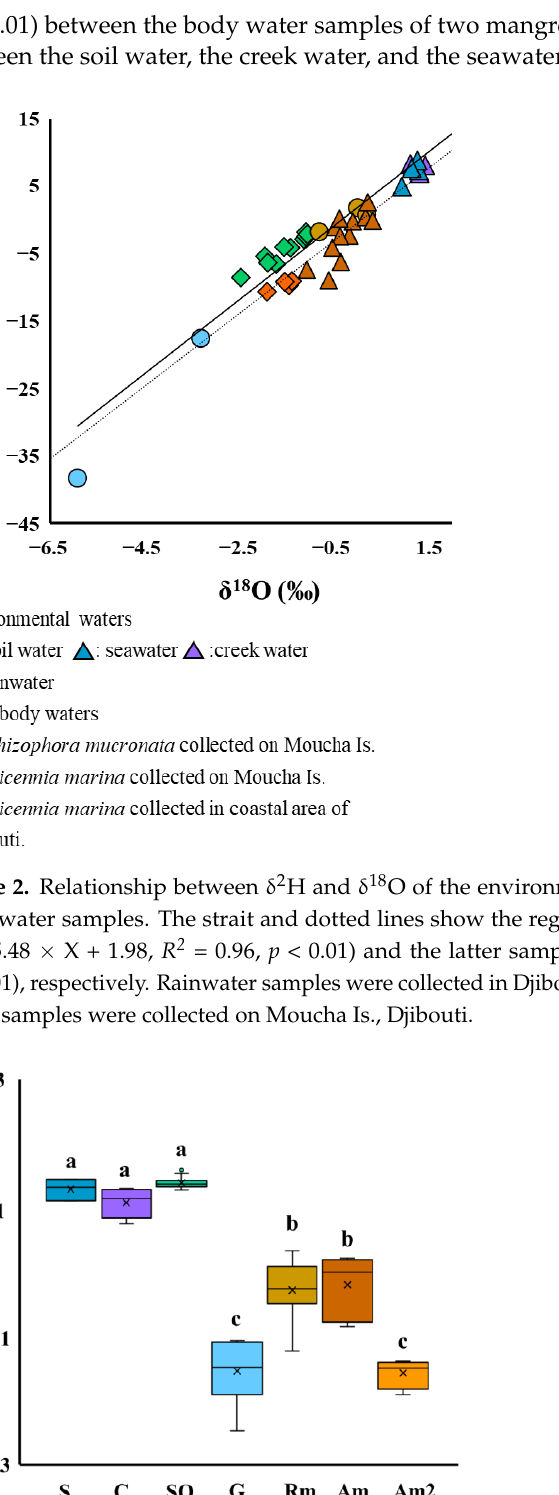
Figure 3. Comparison on δ 18 O in the body water of mangroves with the environmental water in